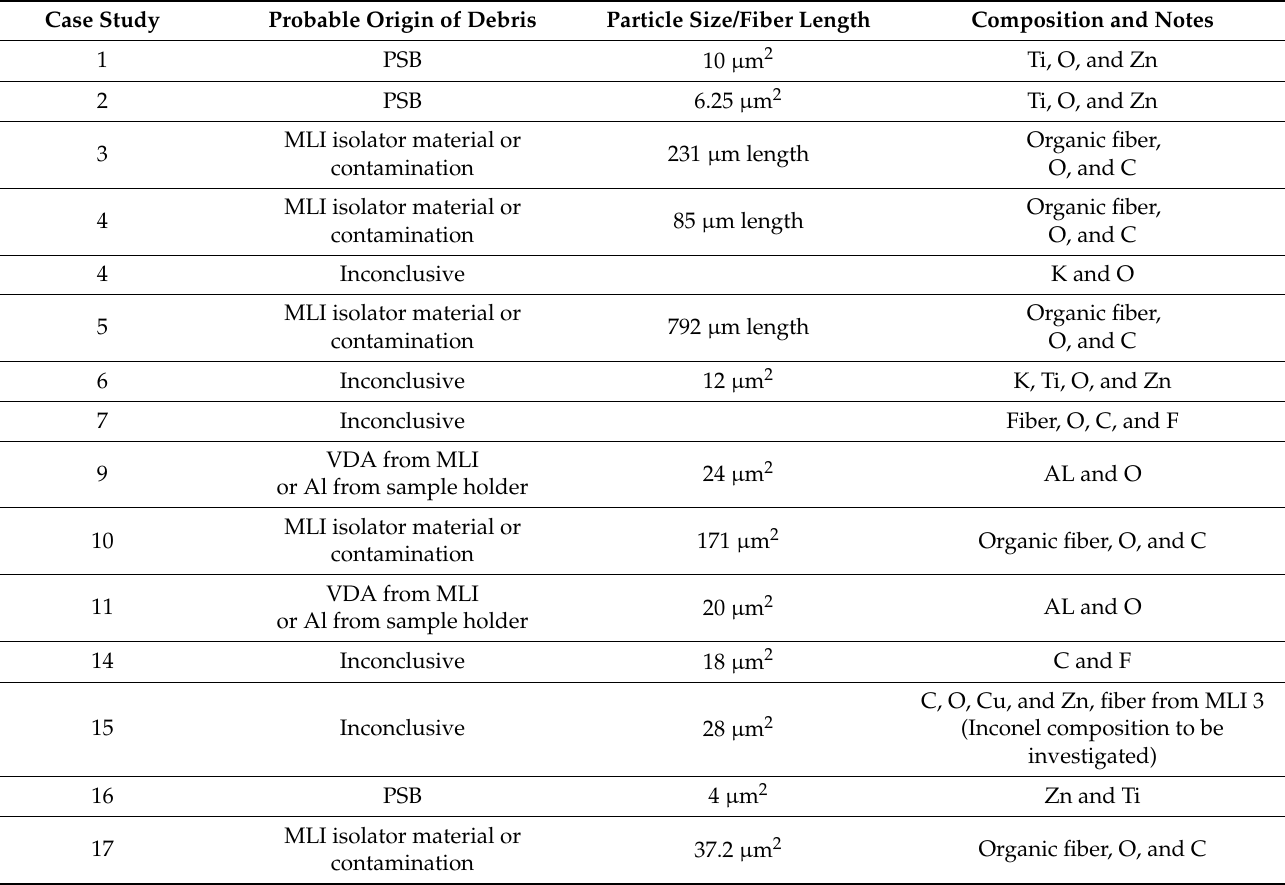
Table 9. LEO ATOX particle size or fiber length and origin